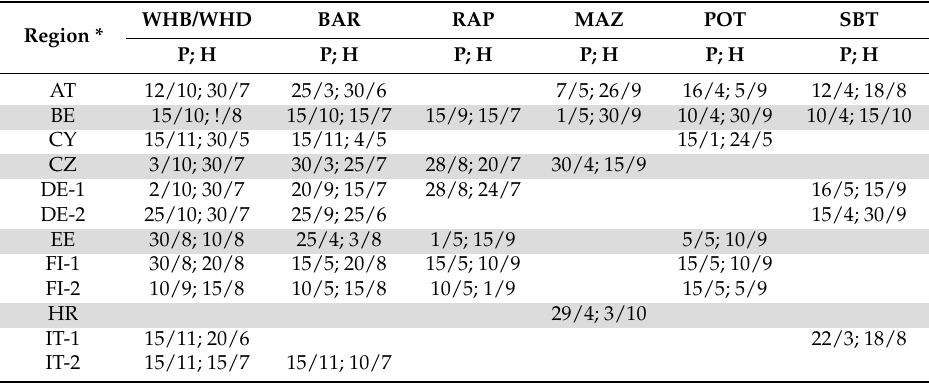
Table A2. Planting (P) and harvesting (H) dates of arable crops in the different regions. Region *